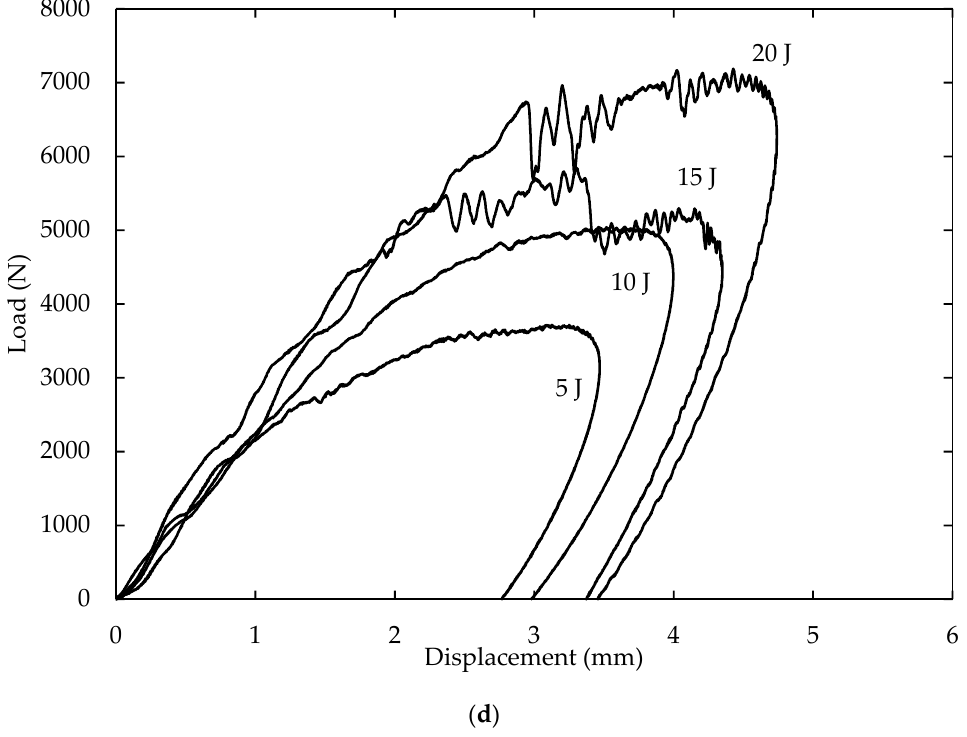
Figure 5. Typical load–displacement traces of ( a ) banana, ( b ) Kevlar, ( c ) glass, and ( d ) carbon/epoxy sandwich structures.